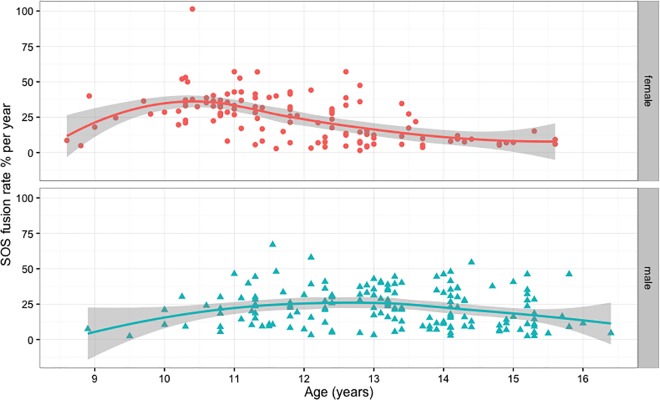
Males and females spheno-occipital synchondrosis closure rate per year (percentage).The Scatterplot with nonlinear fit curve and 95% CI shows the data from Table 7 and Table 8.